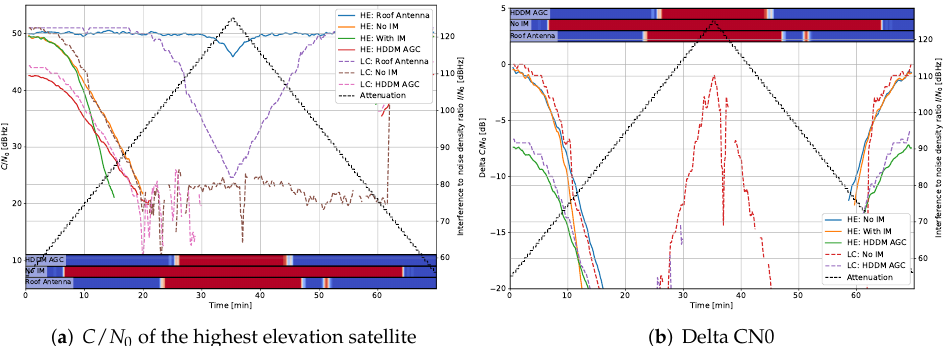
Figure A6. Interference #6: Filtered noise with 4MHz bandwidth with GPS